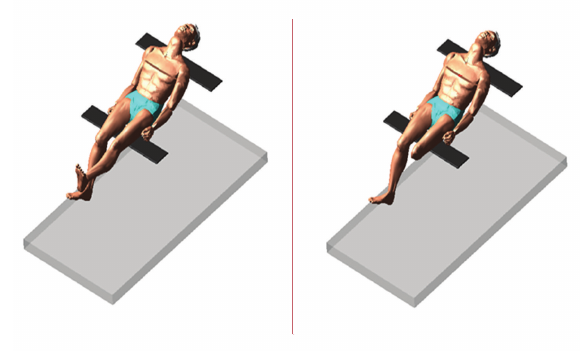
Figure 13: The analysis results for the other patients. Table 3: The maximum deformation and stress comparison.